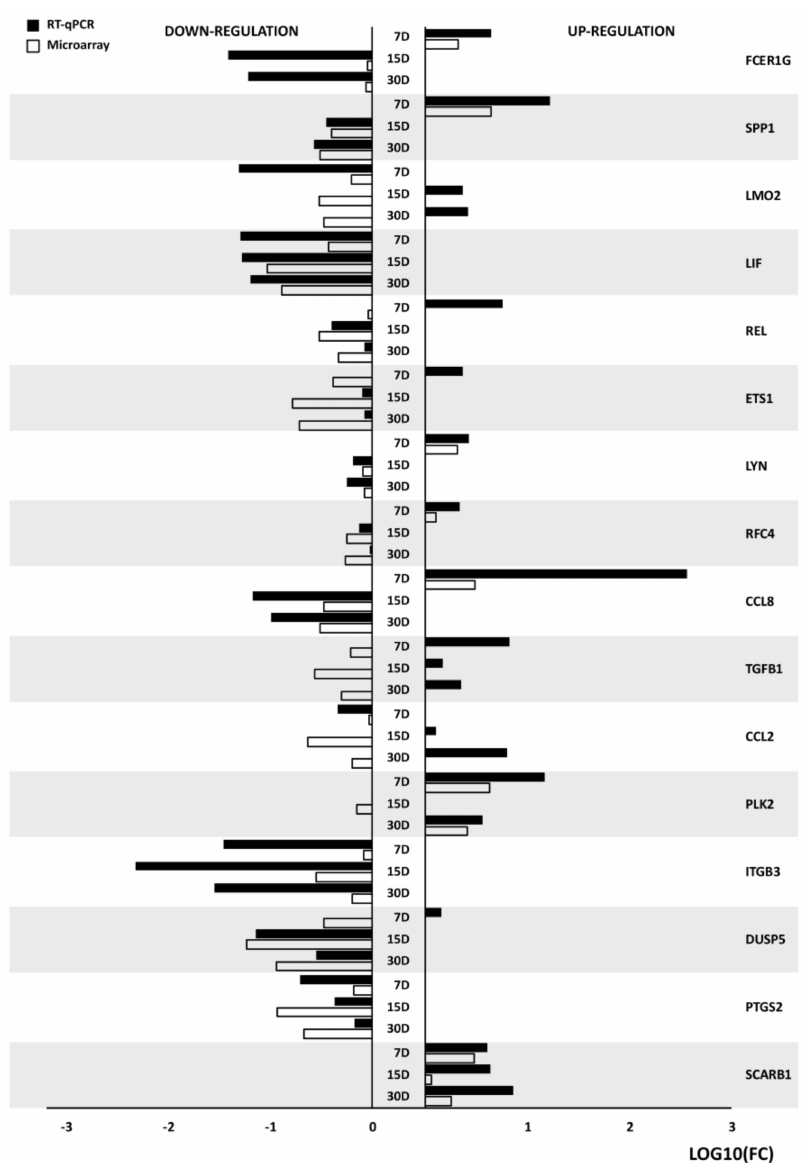
Figure 5. The results of RT-qPCR (Real Time-quantitative Polymerase Chain Reaction) validation of analyzed genes, presented in the form of bar-graph. All the fold changes were described in relation to the transcript levels in 24 h of primary culture. LogFC was used to present the data, in order to improve the clarity and comparability of up and downregulation